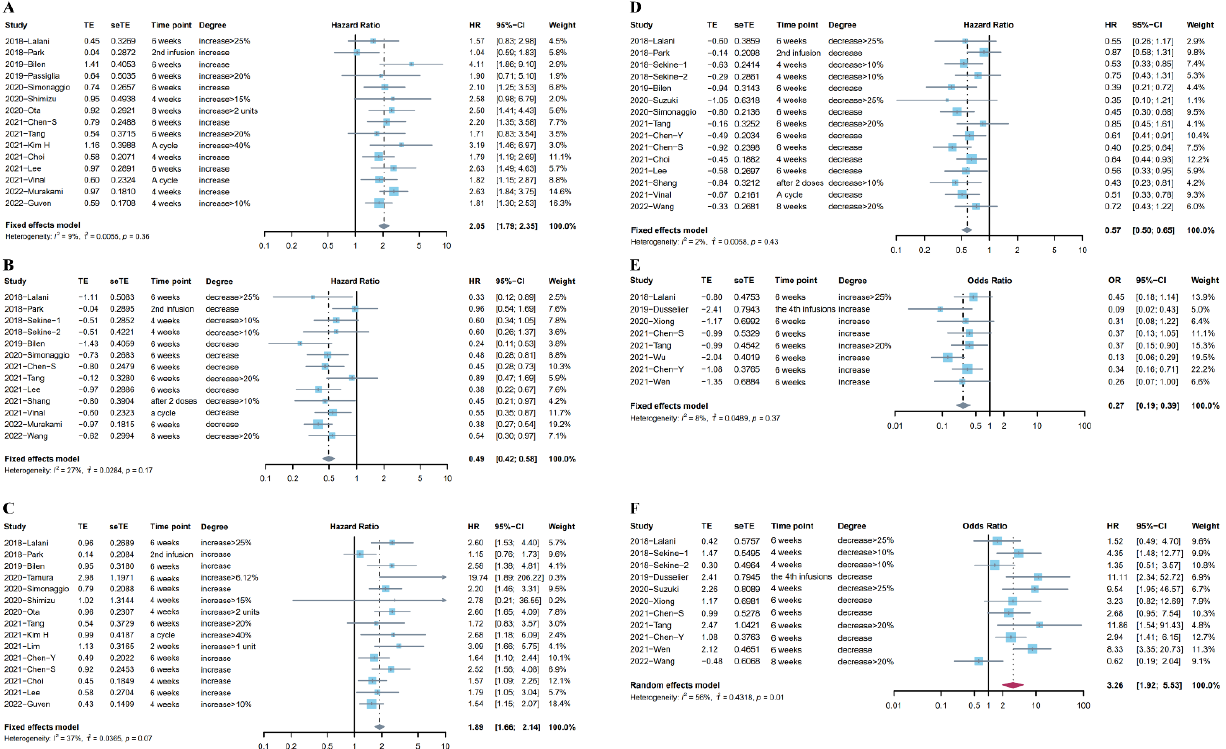
Figure 2. ( A ) Forest plot for the association between upward trend in NLR after ICI treatment and OS. ( B ) Forest plot for the association between downward trend in NLR after ICI treatment and OS. ( C ) Forest plot for the association between upward trend in NLR after ICI treatment and PFS. ( D ) Forest plot for the association between downward trend in NLR after ICI treatment and PFS. ( E ) Forest plot for the association between upward trend in NLR after ICI treatment and ORR. ( F ) Forest plot for the association between downward trend in NLR after ICI treatment and ORR.